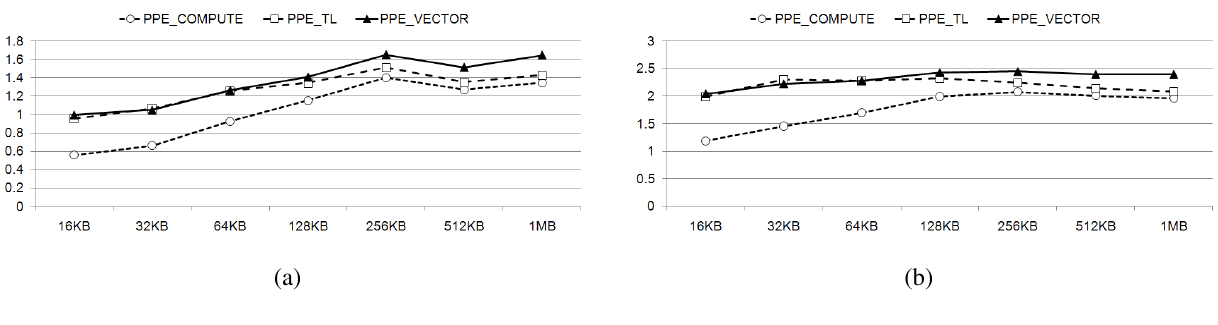
Figure 18. Average speed-up of network coding on real machine with varying data size; ( a ) Intel; and ( b )